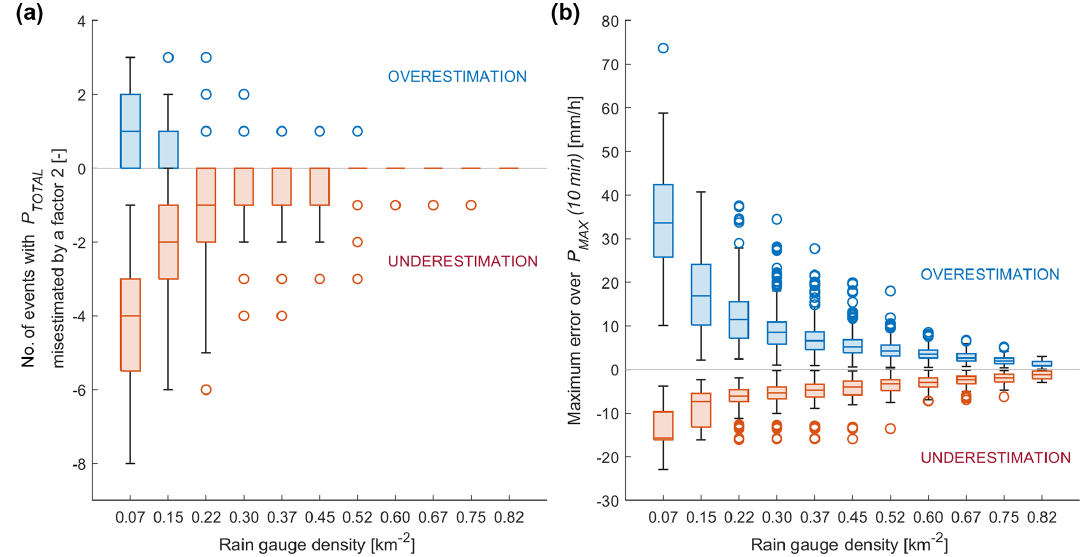
Figure 9. (a) Number of rainfall events for which the total amount of rainfall is overestimated or underestimated by a factor of 2, according to the rain gauge density, going from 0.07 to 0.82 rain gauges per square kilometer (respectively, one to 11 rain gauges within the catchment). (b) Error on the maximum rainfall over 10min P MAX (10min) according to the rain gauge density. For each rain gauge density, all possible combinations of rain gauge networks are tested. The reference value is estimated from the full network of 12 rain gauges. The bottom and top of each box show the 25th and 75th percentiles of the sample, and the middle line is the sample median. The whiskers go up to 1.5 times the interquartile range; values beyond the whiskers (outliers) are marked with